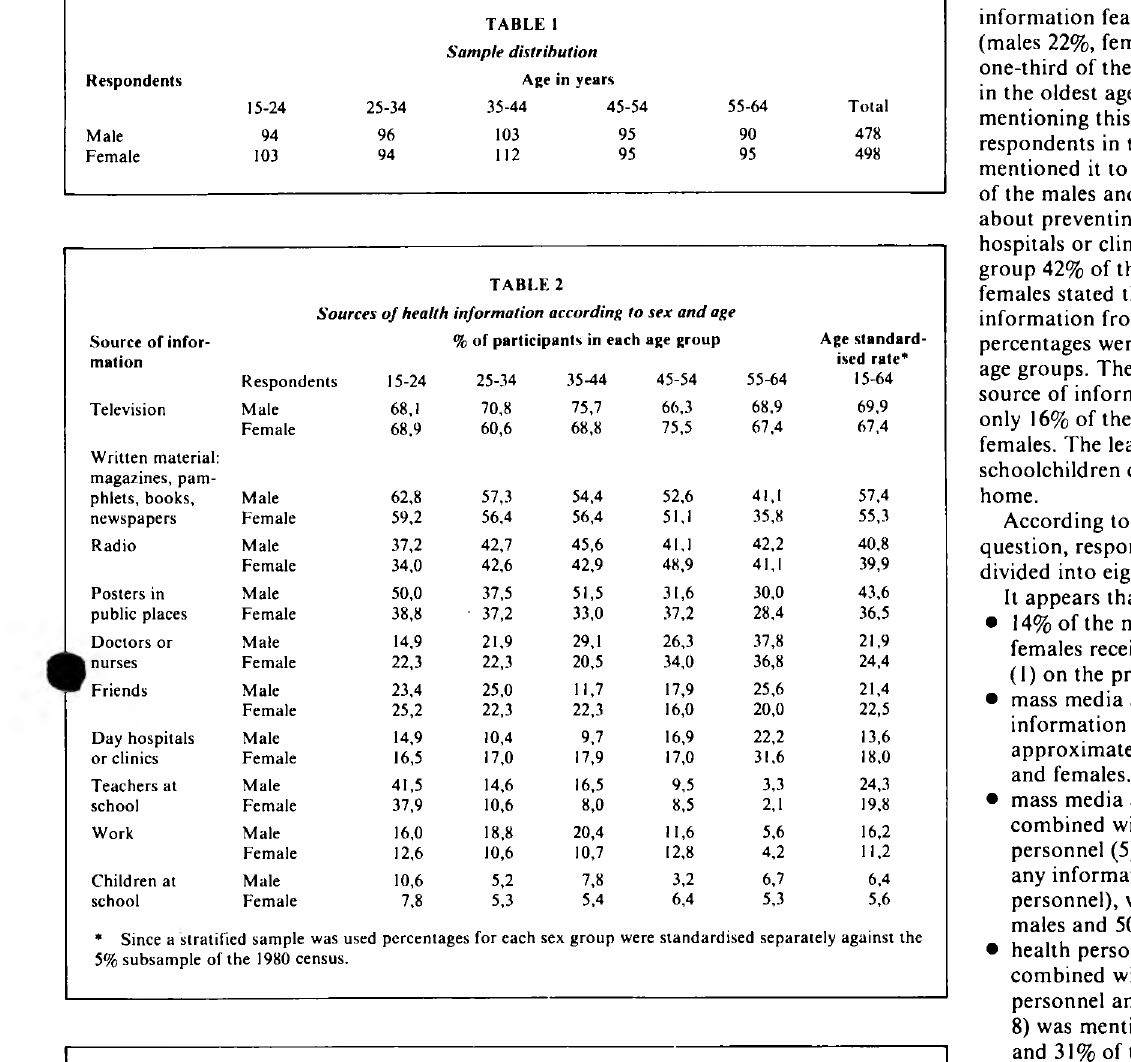
Categorized sources of information on the prevention of heart disease according to sex and